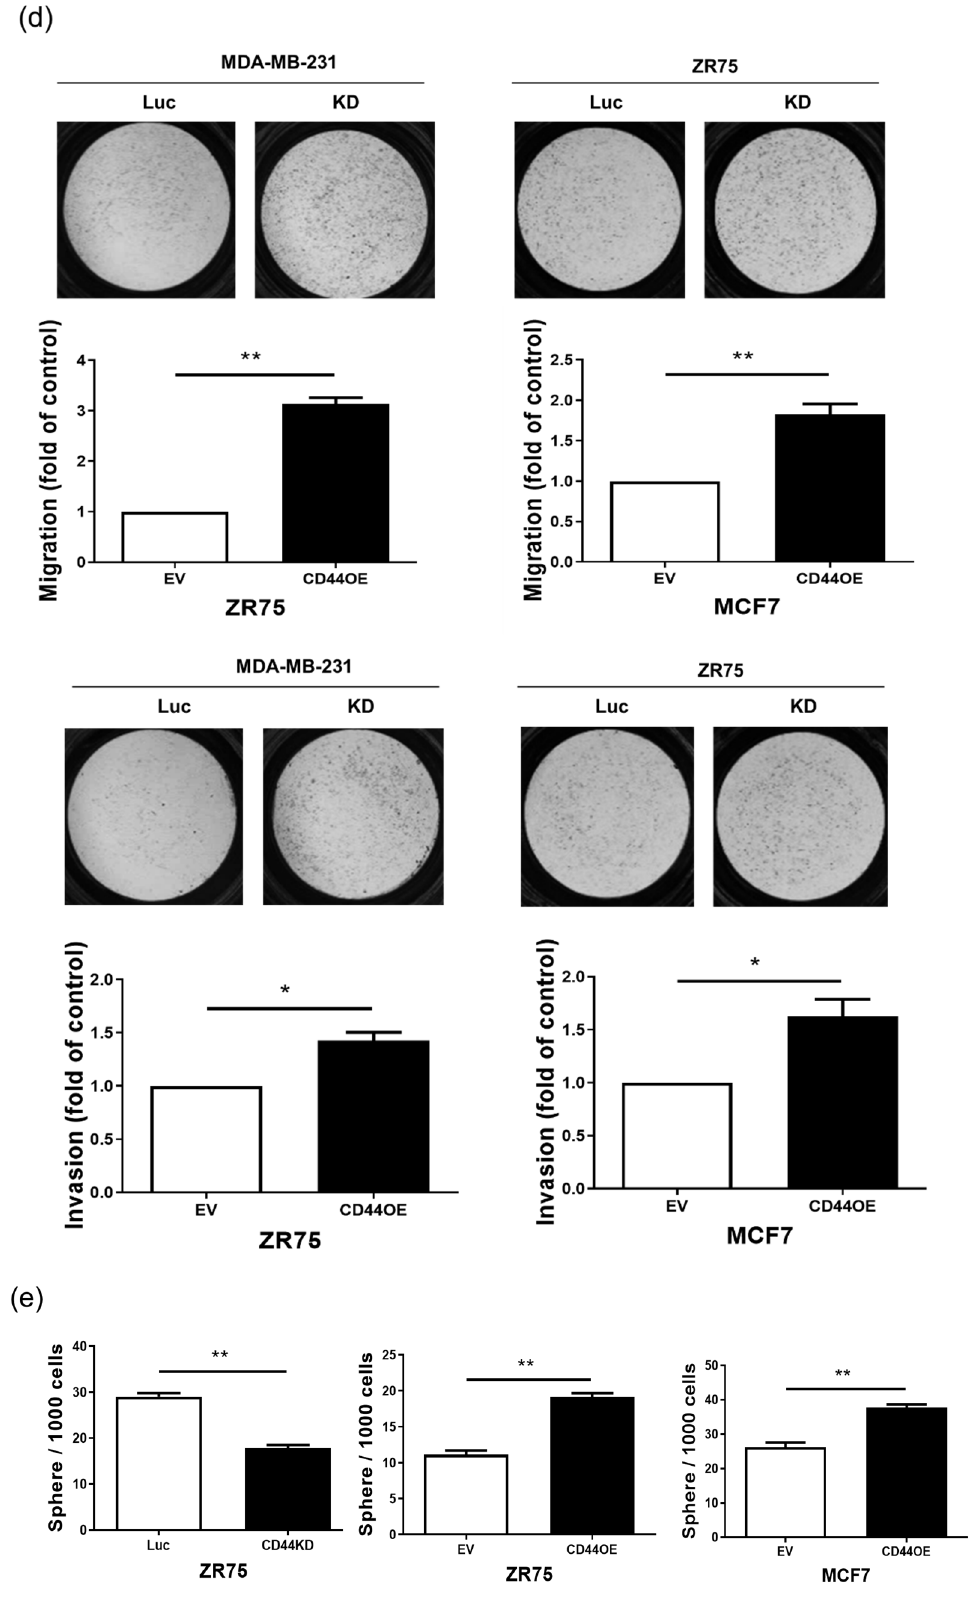
Figure 1. CD44 expression was higher in metastatic lymph nodes, and CD44 knockdown reduced the migration and invasion abilities of breast cancer cells: ( a ) Flow cytometric analysis of CD44 expression in primary breast tumors (T) and paired metastatic lymph nodes (LN) in 14 breast cancer patients’ samples. ( b ) The expression of CD44 in breast cancer tissues, as determined by